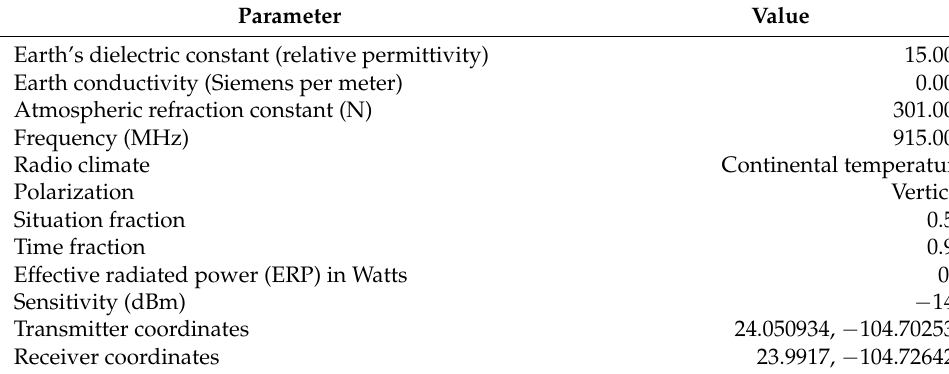
Table 1. Parameters used for radiofrequency studies in